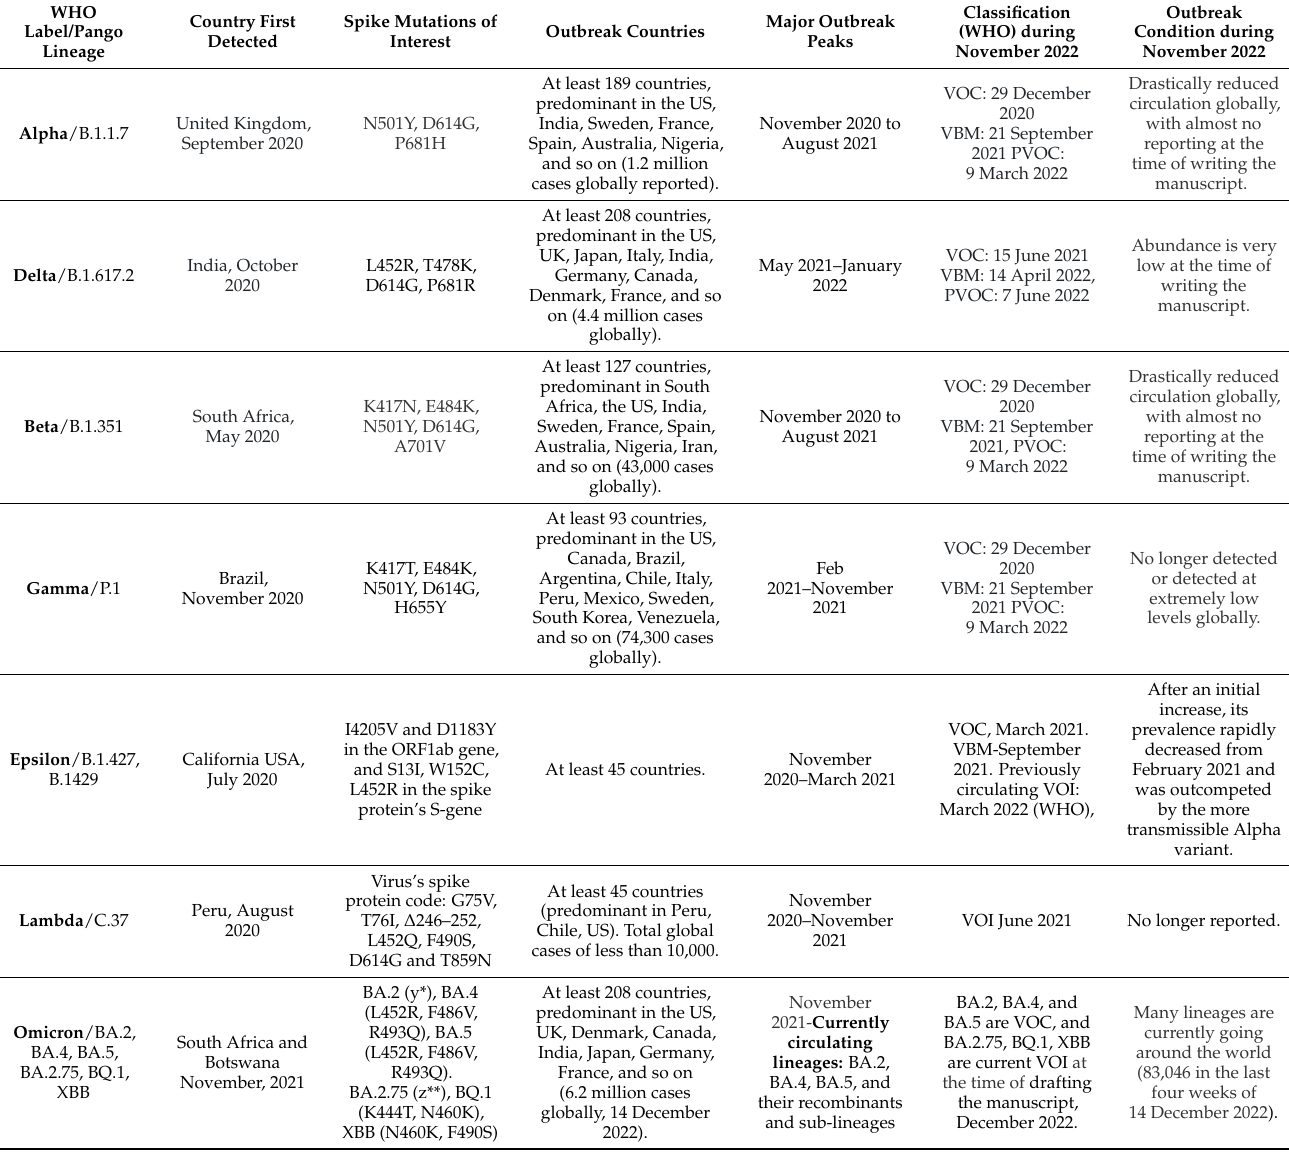
Table 1. SARS-CoV-2 variants and lineages